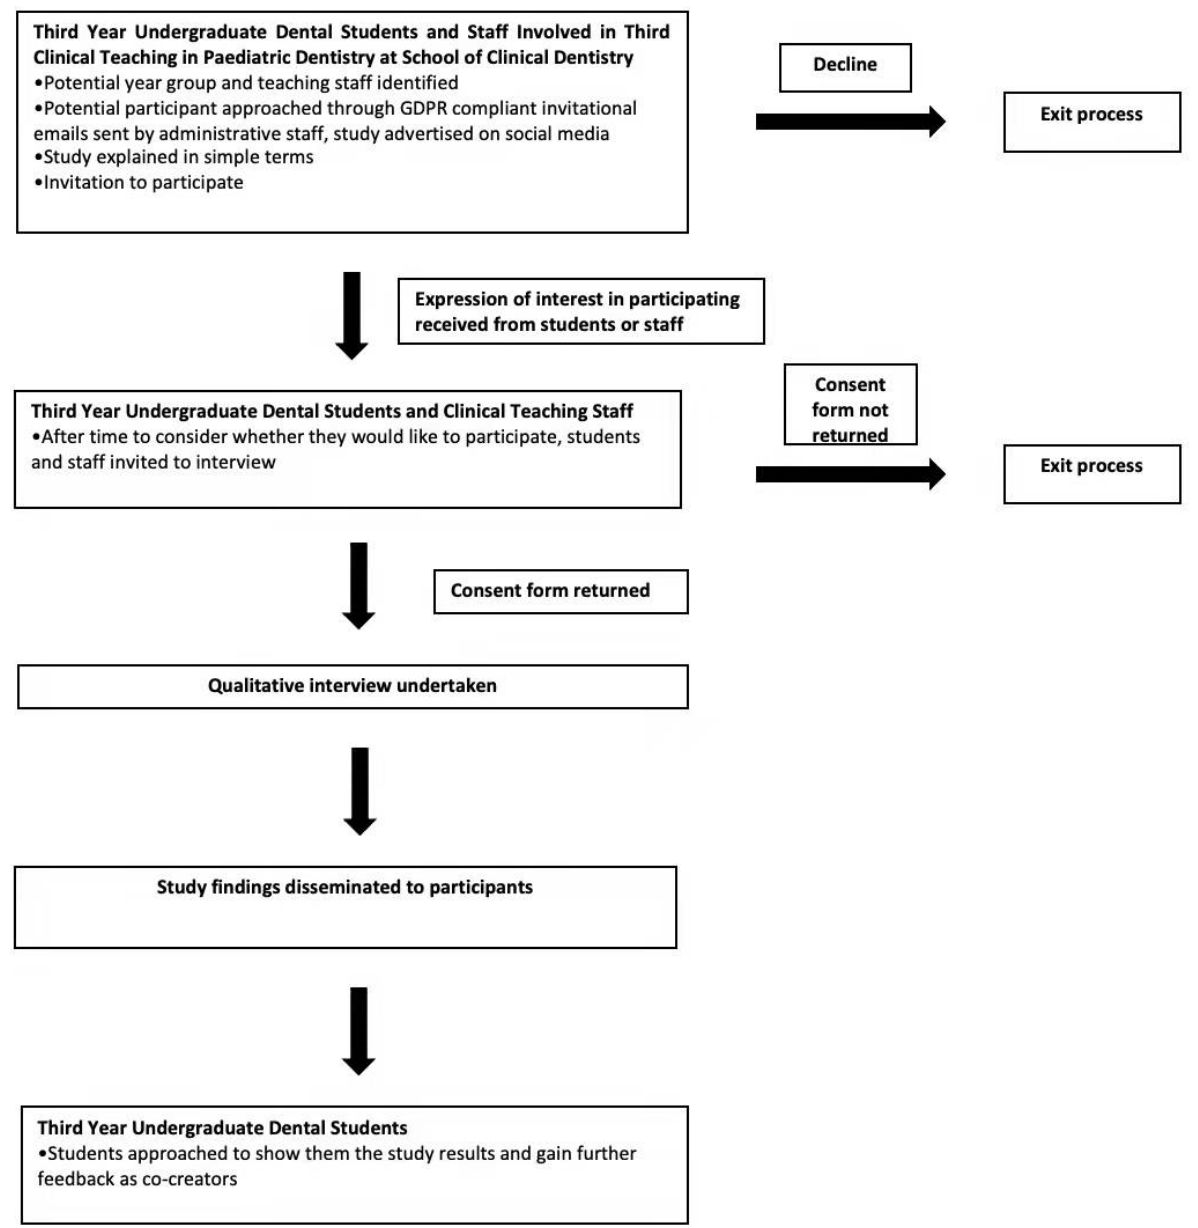
Figure 2. Participant recruitment flowchart .